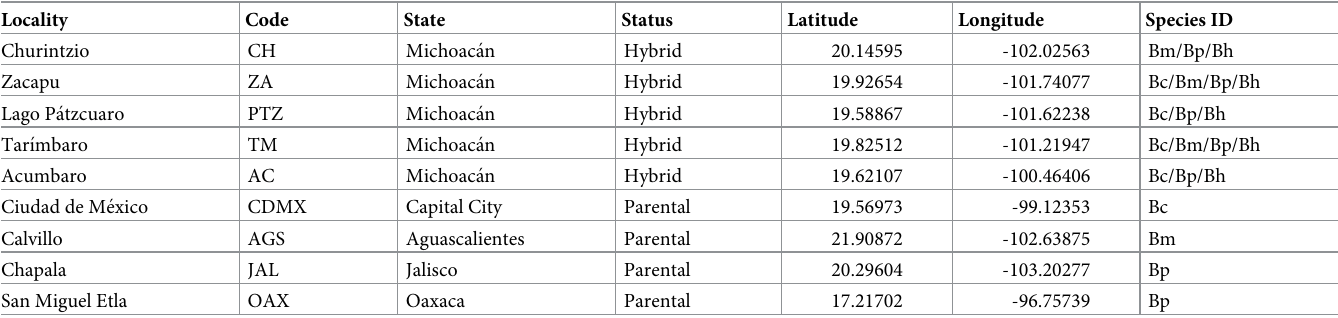
Species abbreviations: B . bipinnata Bp, B . cuneata Bc, B . palmeri Bm, putative hybrids Bh. Sample sizes for each locality see Fig 1.